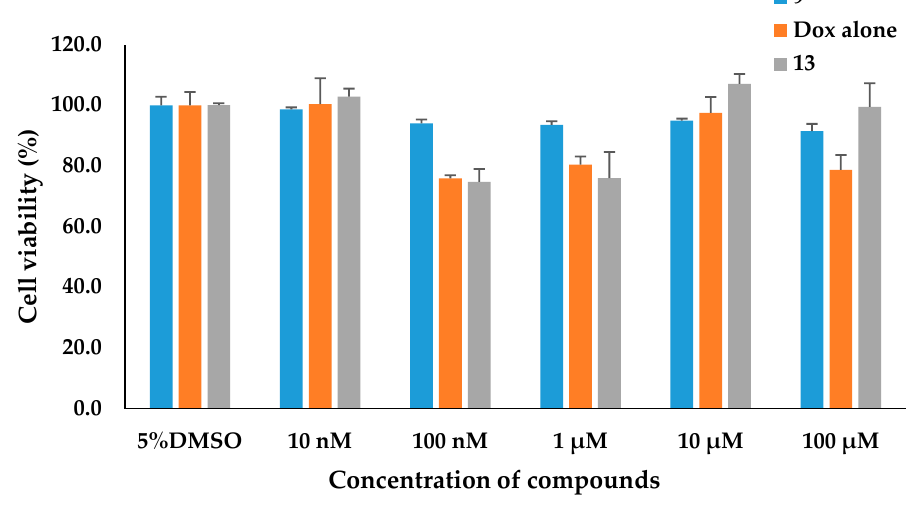
Figure 8. Cytotoxicity of peptide 9 , conjugate 13 (Dox-s-s-CGFLG-C6-[KTVRTSADE]) and Dox on a PC3 prostate cancer cell line after two hours of incubation at various concentrations.